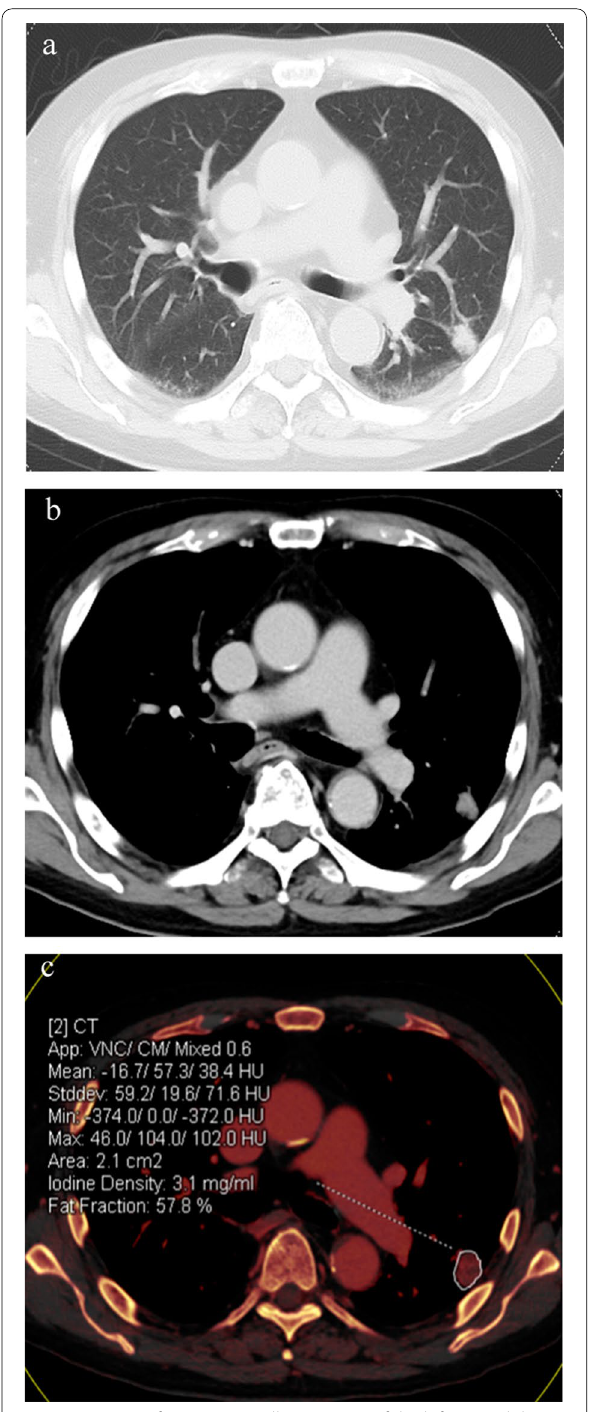
Fig. 2 Imaging of squamous cell carcinoma of the left upper lobe with negative LVI in a 73-year-old man ( a – c ). ( a ) Lung window image of the tumor, ( b ) Iodine-enhanced DECT image of the tumor, ( c ) The ROI of the maximum tumor diameter on an iodine-enhanced axial image (oval ROI), FVF was 57.8%